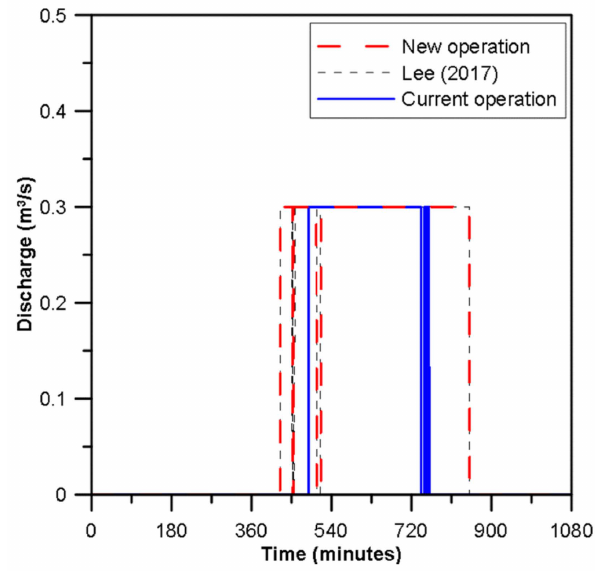
Figure 13. Discharge of the decentralized reservoir in 2010